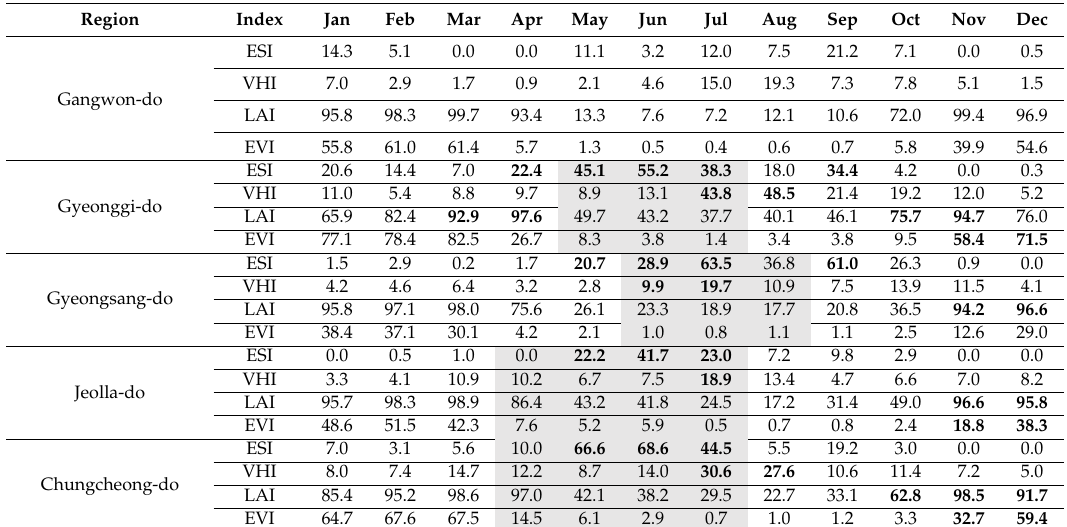
Table 2. Comparison of drought rate by region and actual drought periods, South Korea, 2017 (%). Region